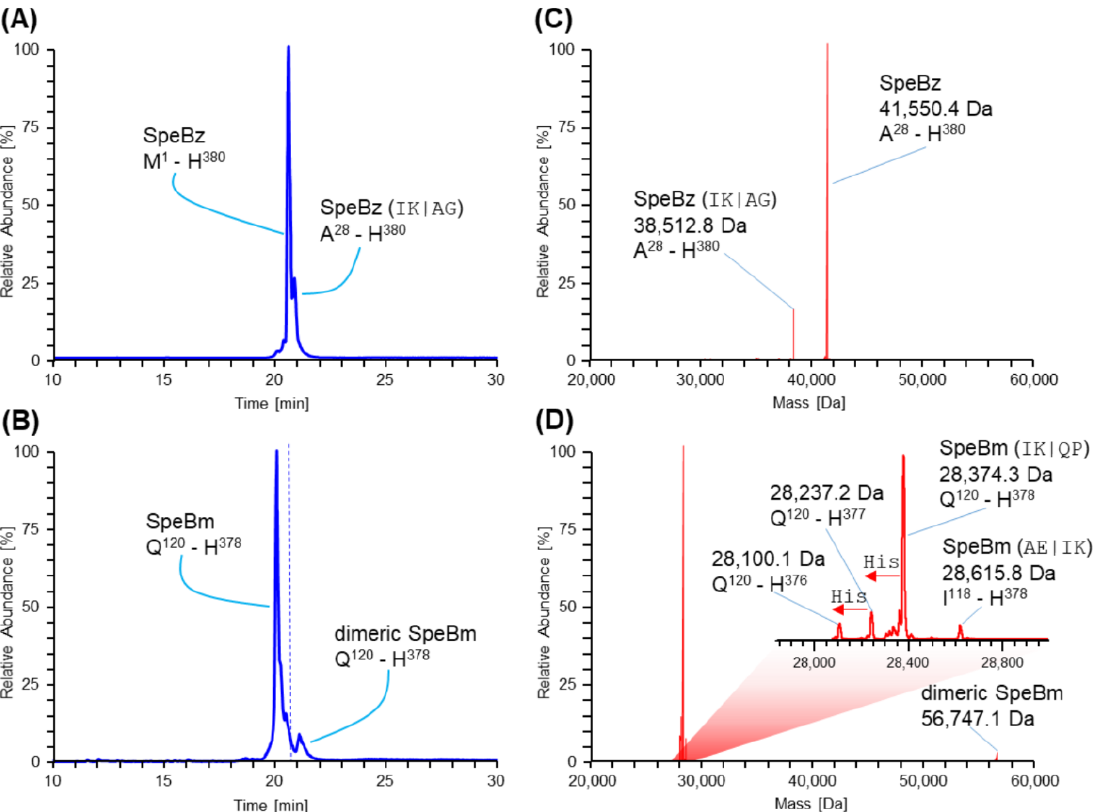
Figure 1. Characterization of recombinant SpeBz and SpeBm by means of HPLC-MS. Panel ( A ) and ( B ) show total ion current chromatograms (TICCs; blue) of MMTS-inhibited zymogenic SpeBz and activated SpeBm, respectively. The chromatographic peaks are labeled according to their deconvoluted masses (red) as determined by hyphenated mass spectrometric analysis (panels ( C ) and ( D )). Depicted amino acid sequence numbers of protein species correspond to Figure S1D. Of note, residue Q 120 corresponds to Q 146 in the UniProt entry P0C0J0. This offset originates from construct design, lacking the signal peptide. To ease the comparison of the two chromatograms, a dashed blue line shows the retention time of SpeBz observed in panel ( A ) in panel ( B ). To distinguish different SpeB species, the specific cleavage site is listed in brackets ( C , D ). Mass shifts of SpeBm caused by degradation of the His-tag are indicated with red arrows and “His”.